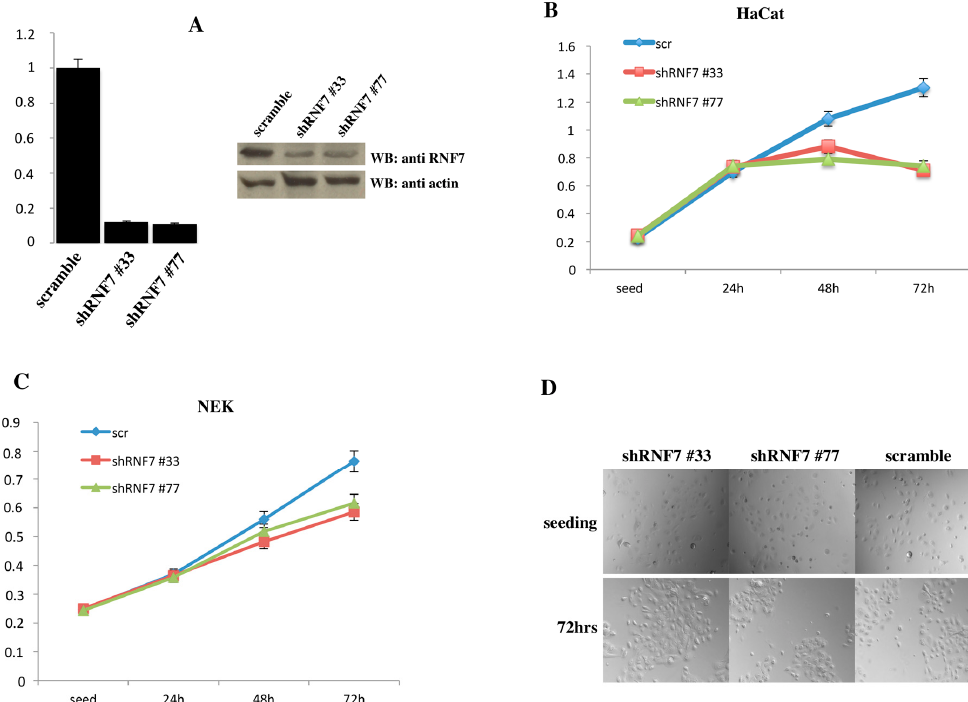
Figure 4. RNF7 depletion results in cell death ( A ) Left panel: HaCaT cells were infected with retroviral vectors encoding for two different short hairpin RNAs (shRNAs) targeting RNF7 or a control shRNA (scramble). After selection, RNF7 mRNA levels normalized to glyceraldehyde 3-phosphate dehydrogenase (GAPDH) were quantified by real-time PCR. Right panel: In the same cells RNF7 expression was monitored by immunoblot assay. ( B ) HaCaT cells and ( C ) human normal epidermal keratinocytes were infected with a lentiviral vector expressing a scramble sequence or shRNAs targeting RNF7 and cell viability was monitored at the indicated time points by 3-(4,5- dimethylthiazol-2-yl)-2,5-diphenyltetrazolium bromide (MTT) assay. ( D ) 20× phase contrast micrographs of the human normal epidermal keratinocytes used in the experiment shown in ( C ). NEK: normal epidermal keratinocytes.